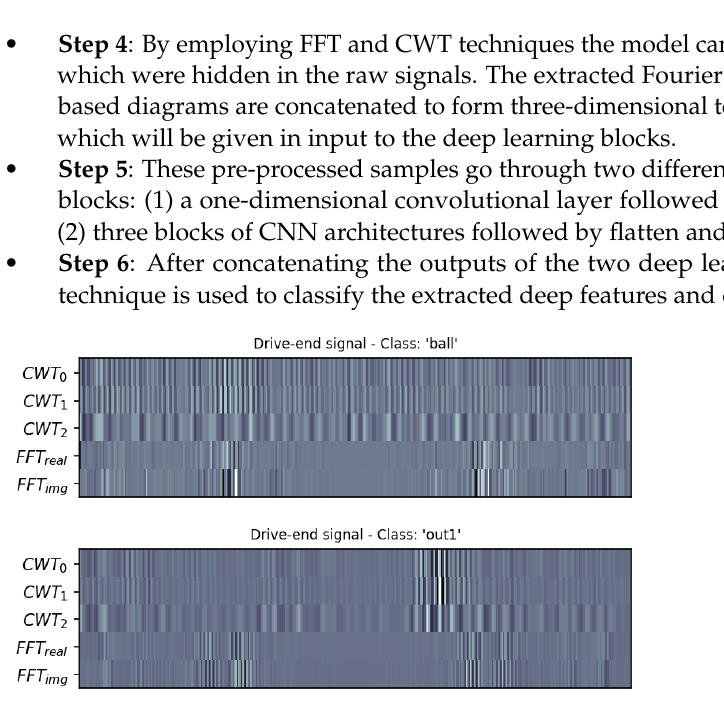
Figure 5. The output of Step 4—Two tensors concatenating the extracted